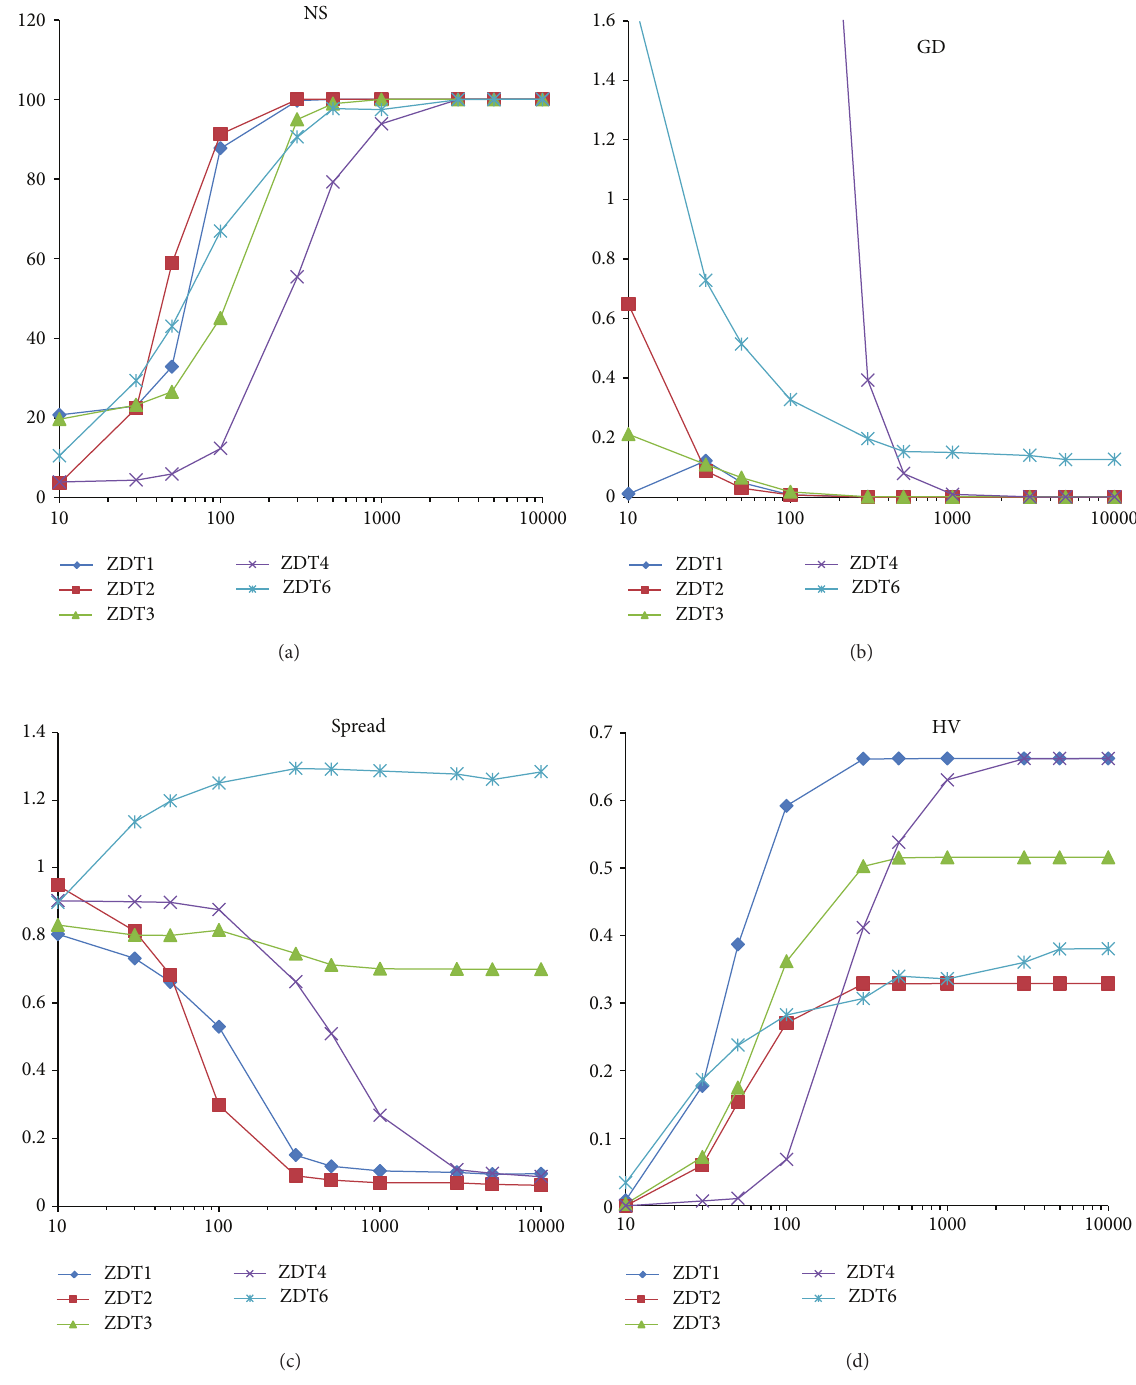
Figure 12: Plots of the performance metrics for various numbers of iterations. (a) Number of solution. (b) Generational distance. (c) Spread. (d)